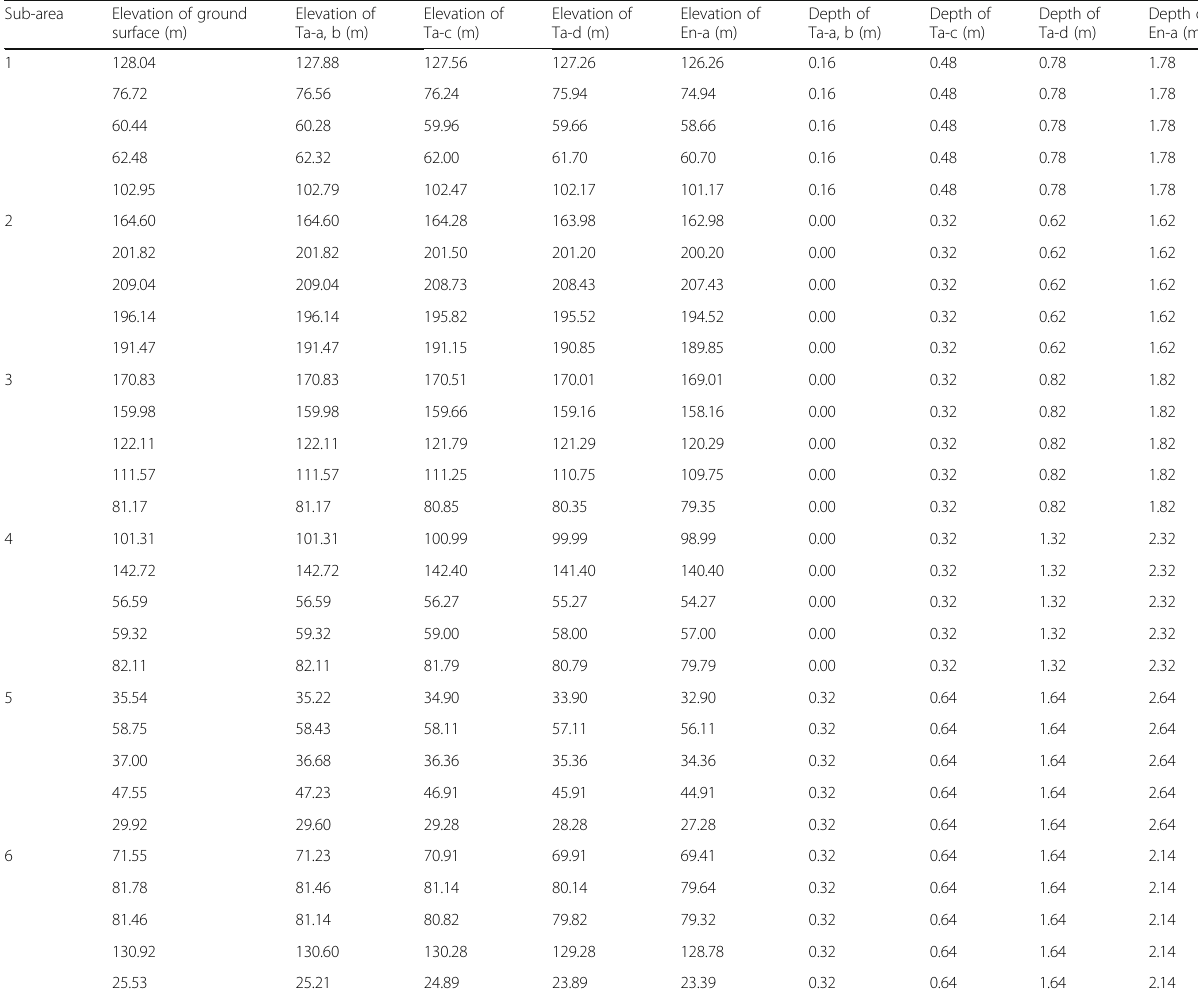
Table 3 Elevations and depths of the pyroclastic fall deposits in the six sub-areas Sub-area